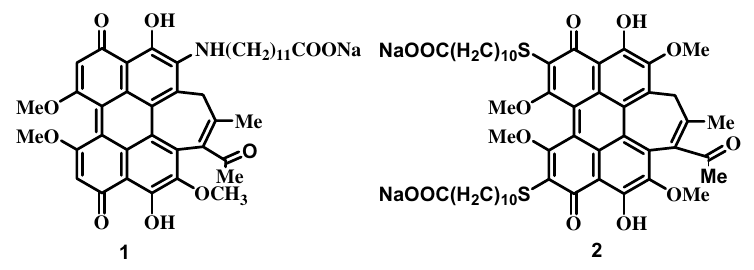
Fig. 2. The molecular structures of 1 and 2 .